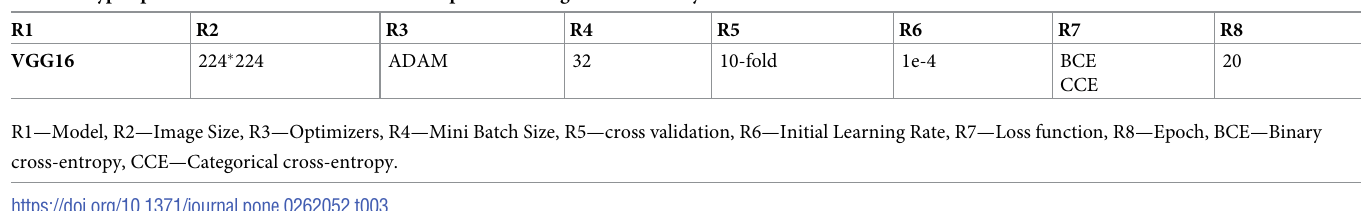
filters’ output is then stacked along the channel dimension and then fed into the next network layer. The Inception V3 framework present in the Keras core obtained from the later released